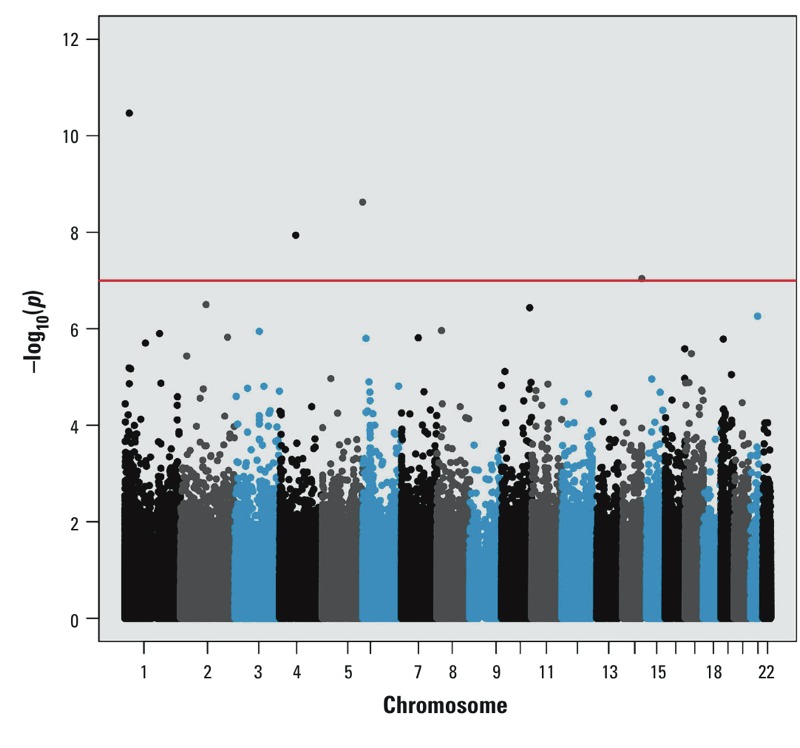
Manhattan plot for epigenome-wide association results for urinary total arsenic concentration. The horizontal red line corresponds to the significance threshold p = 1 × 10–7. Colors are used only to differentiate chromosomes.